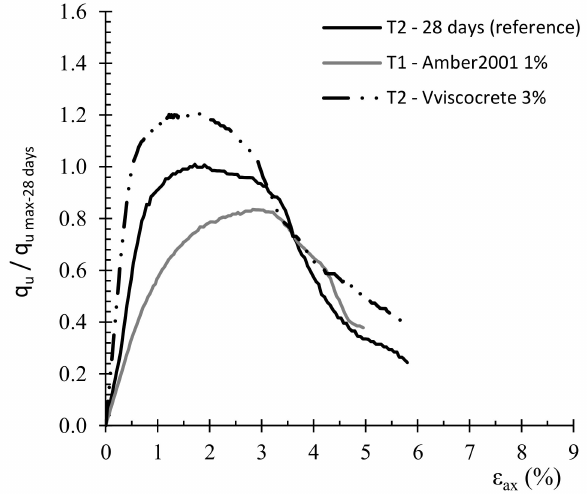
Figure 5. Stress–strain normalized curves (for samples with 28 curing days) for the stabilized soil with only a surfactant solution of Amber 2001 (conc. of 1%) and Viscocrete (conc. of 3%).